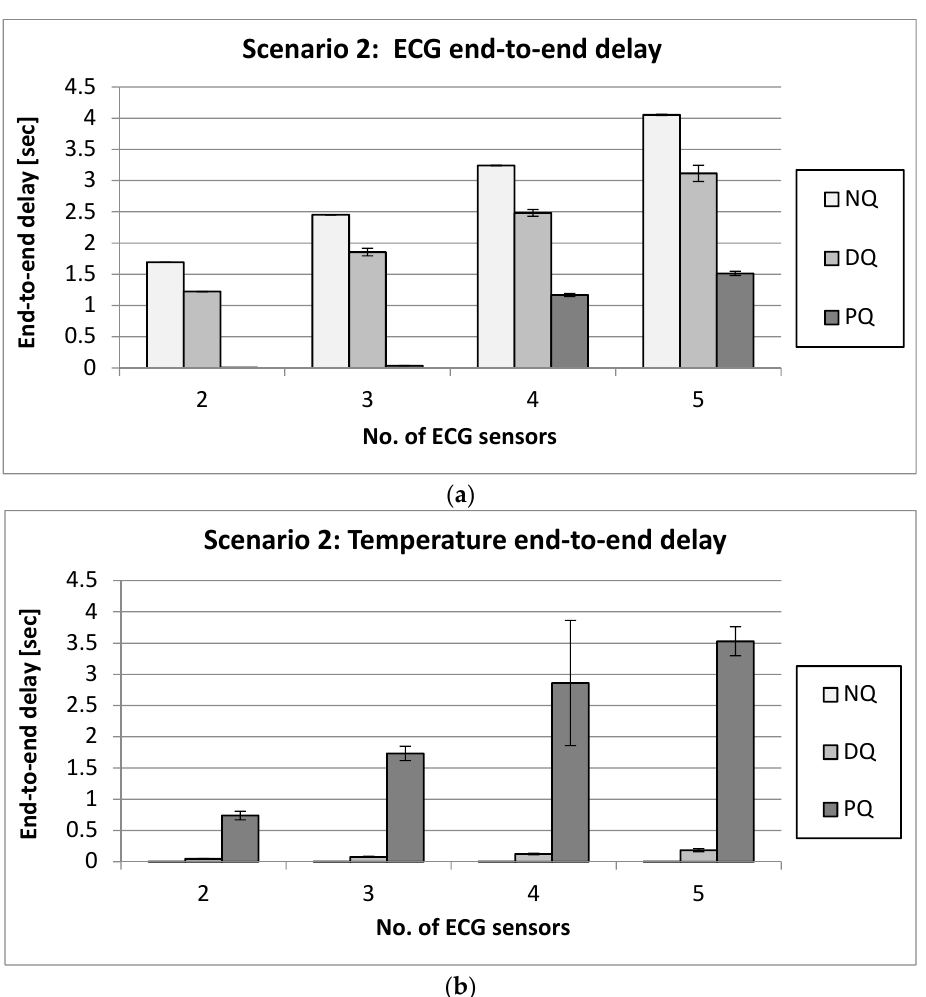
Figure 8. Average end-to-end packet delay results comparison for various data traffic types .